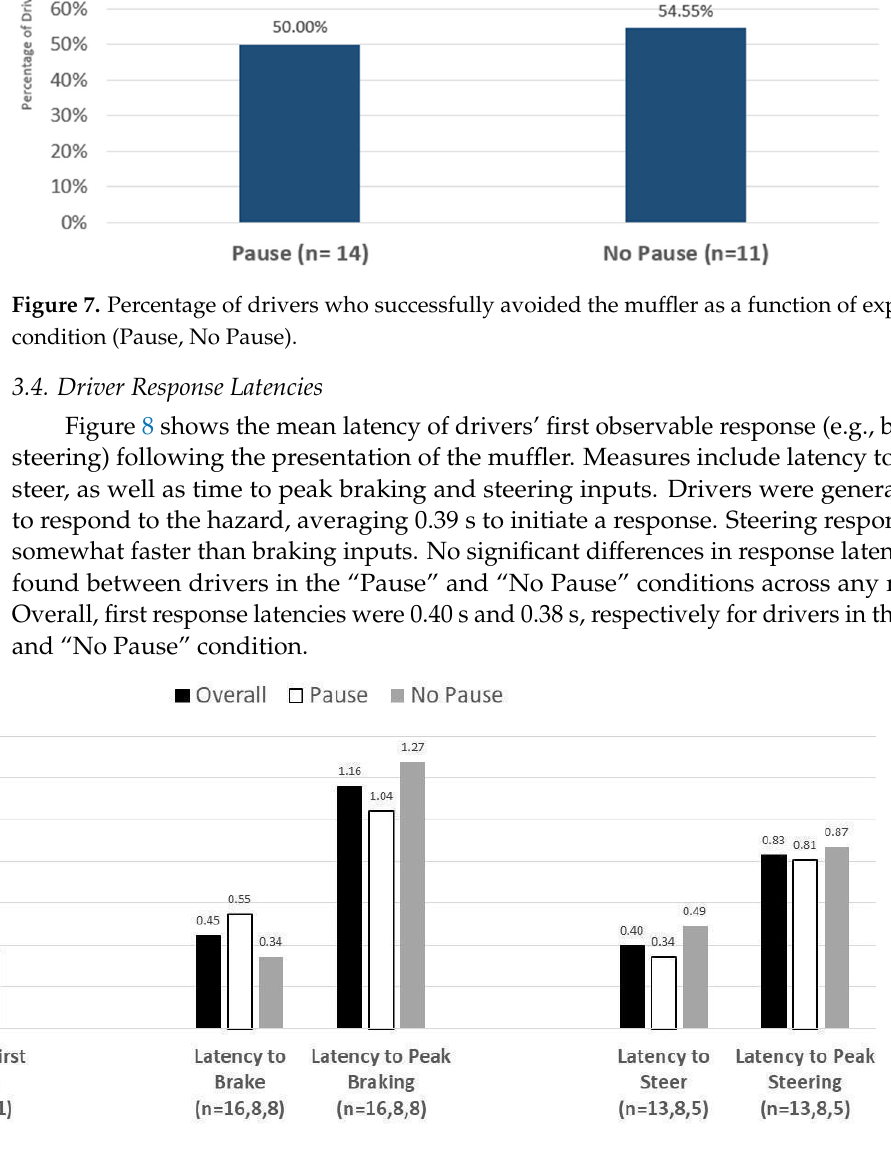
Figure 8. Mean latency to driver’s first response, overall and by experimental condition (number of participants are indicated in the parenthesis for Overall, Pause, and No Pause).